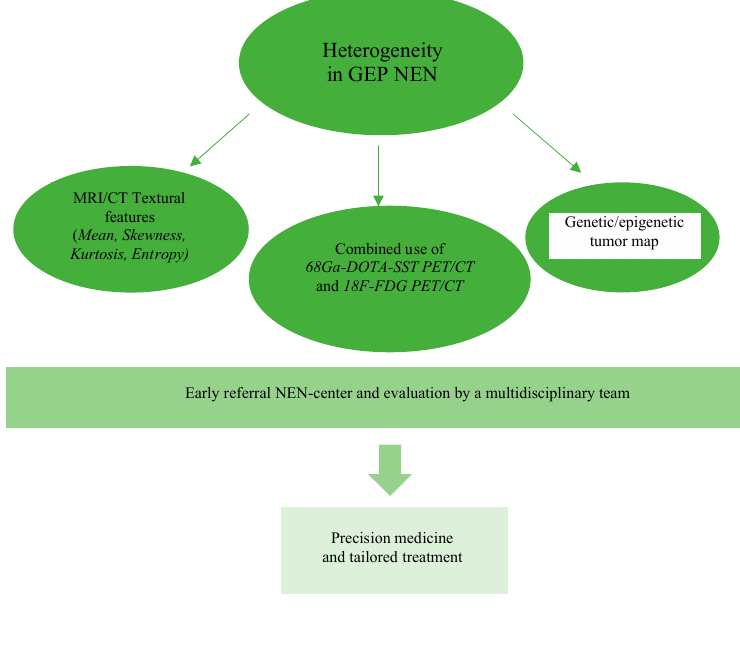
Figure 1. Future Directions in GEP NEN.